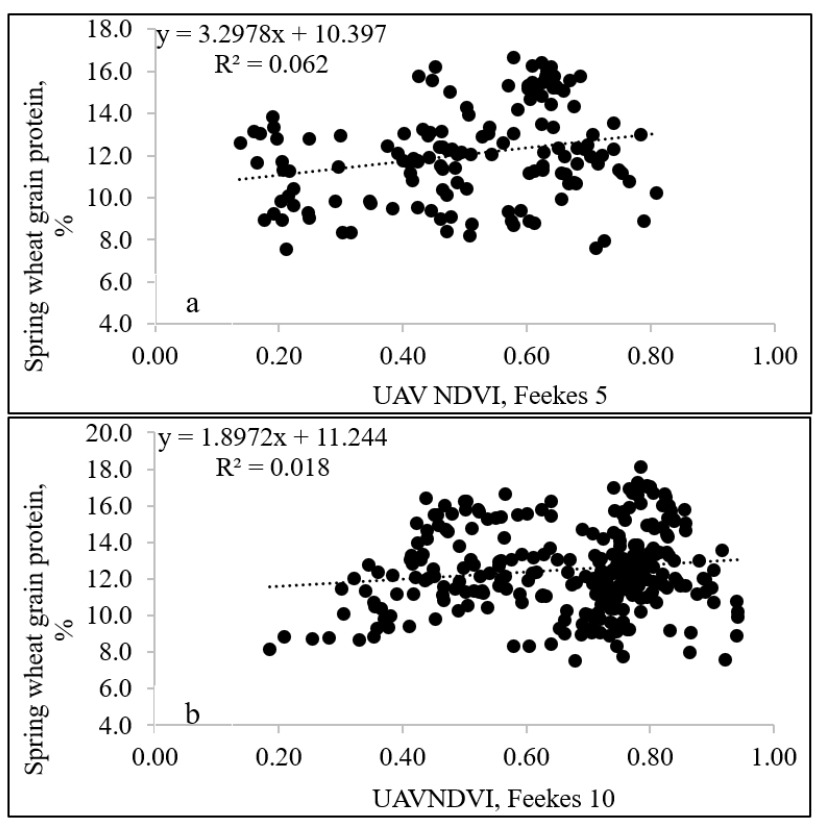
Figure 8. Relationship between Normalized Difference Vegetative Index (NDVI) at Feekes 5 ( a ) and Feekes 10 ( b ) growth stages collected using the Unmanned Aerial Vehicle (UAV) 3D Robotics 8X+ octocopter equipped with MicaSense Red Edge ™ 3 Multispectral Camera and spring wheat grain protein content (%) for 14 site-years in Idaho, 2015 – 2017.